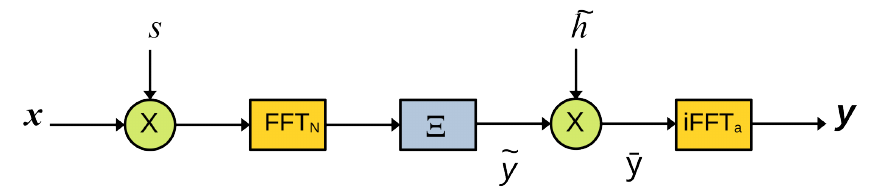
Figure 8. Fast simulation. Dotted arrows are for a elements, full arrows are for N